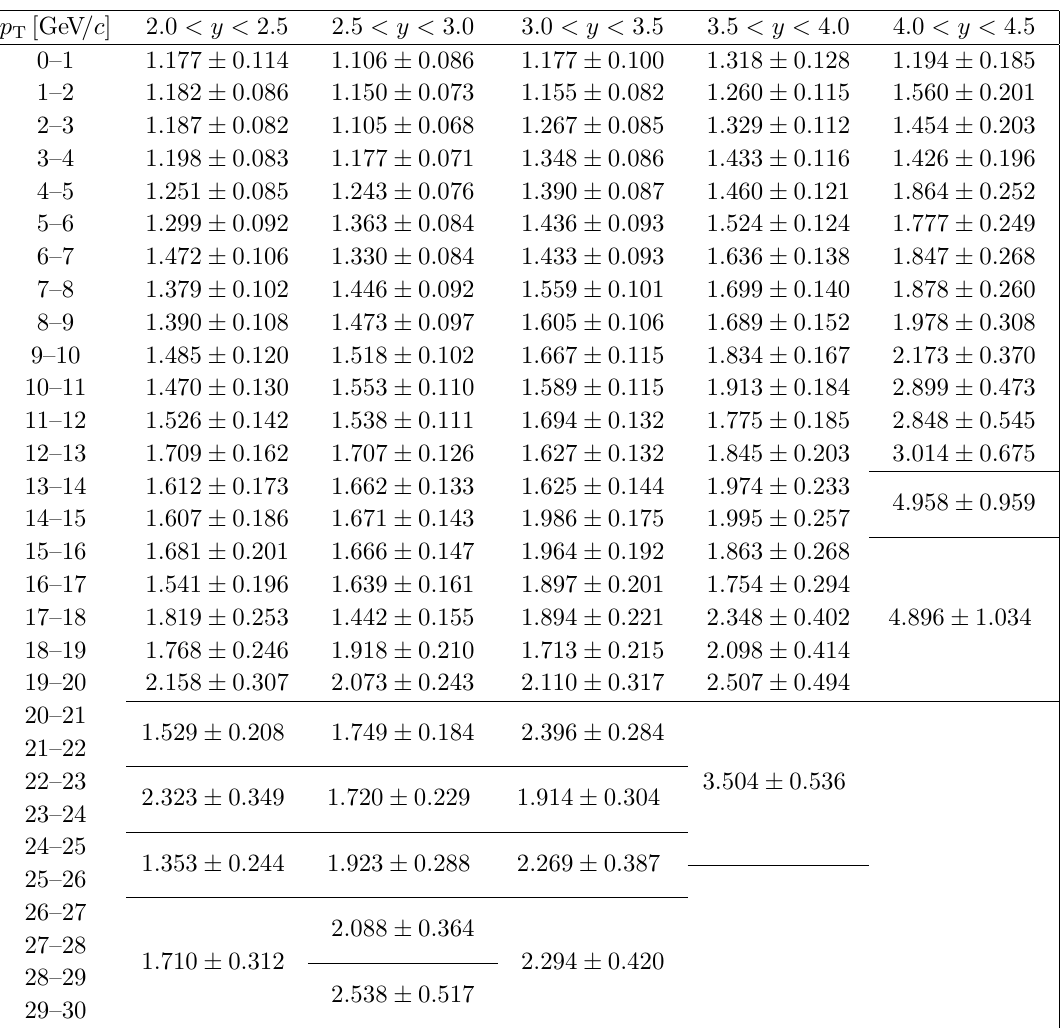
Table 6 . The cross-section ratios between 13 TeV and 8 TeV in di(cid:11)erent bins of p T and y for (cid:7) (2 S